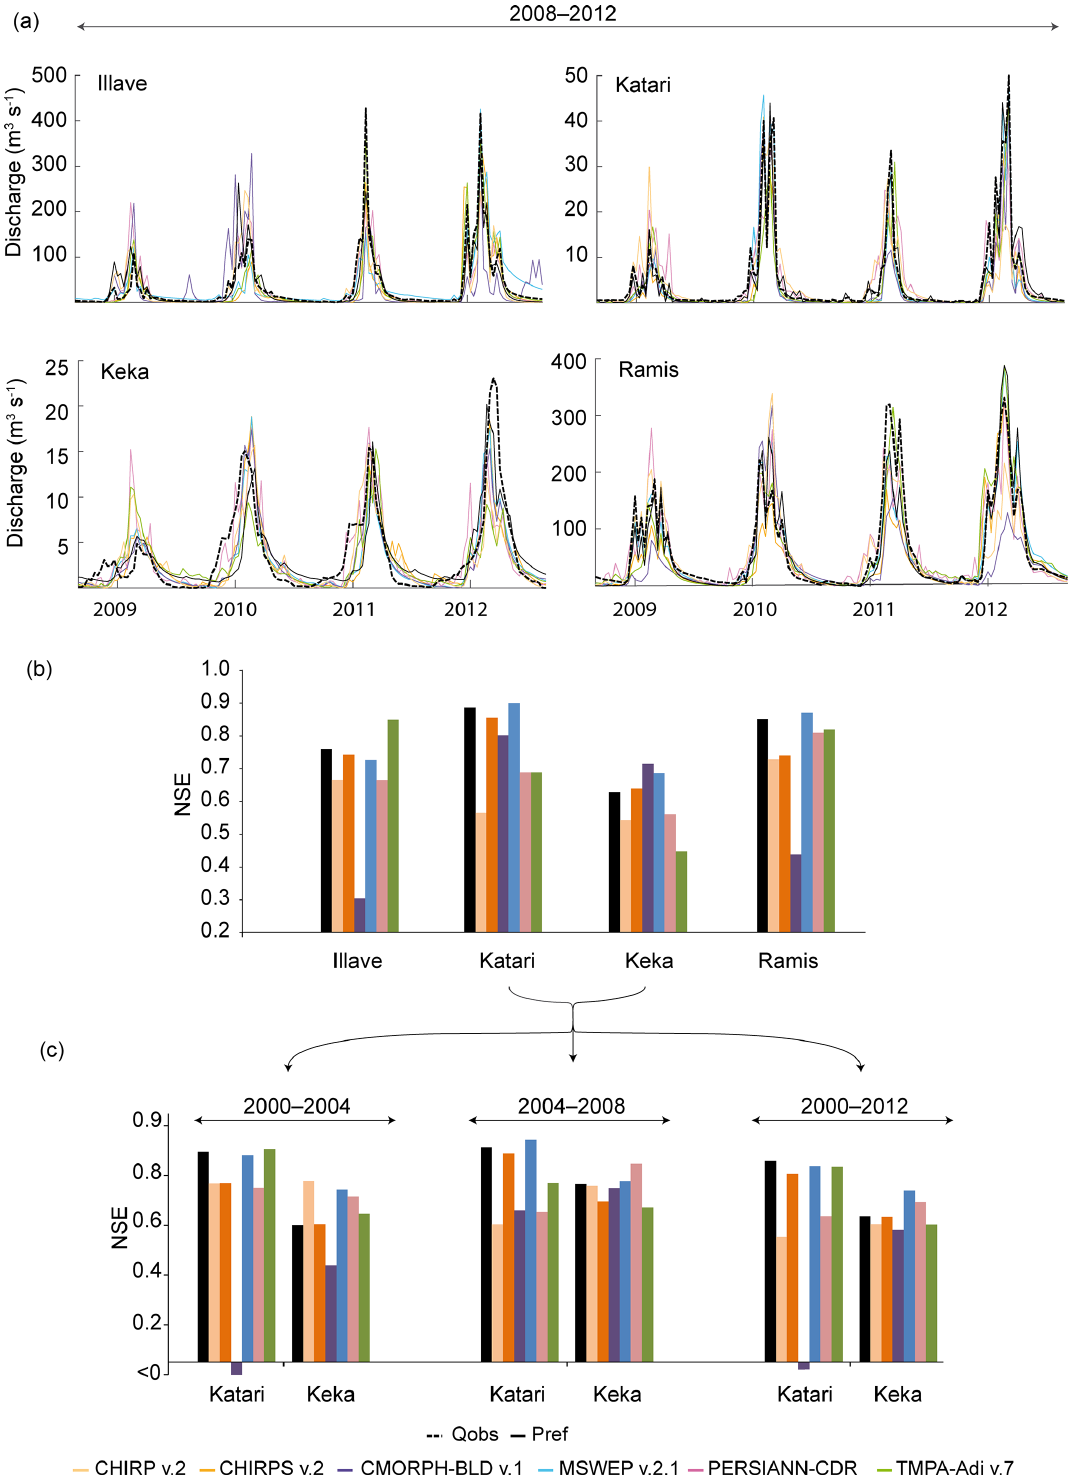
Figure 7. Observed versus simulated streamflow using P ref and SPPs as input data in the hydrological model: (a) 10-day streamflow simu- lations at the four basin outlets (Ilave, Katari, Keka and Ramis) over the 2008–2012 calibration period; (b) corresponding efficiency (NSE scores) of simulated versus observed streamflow; (c) efficiency (NSE score) of simulated versus observed streamflow over the